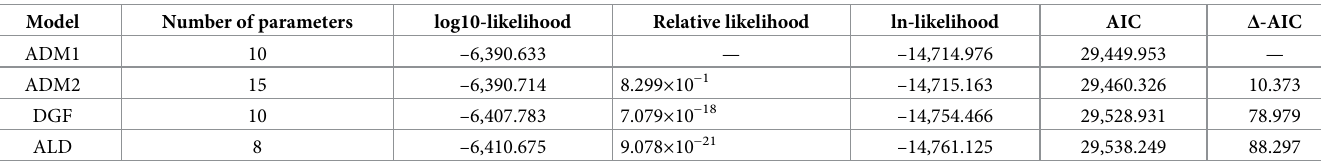
Table 1. Support for each two-population model. Model Number of